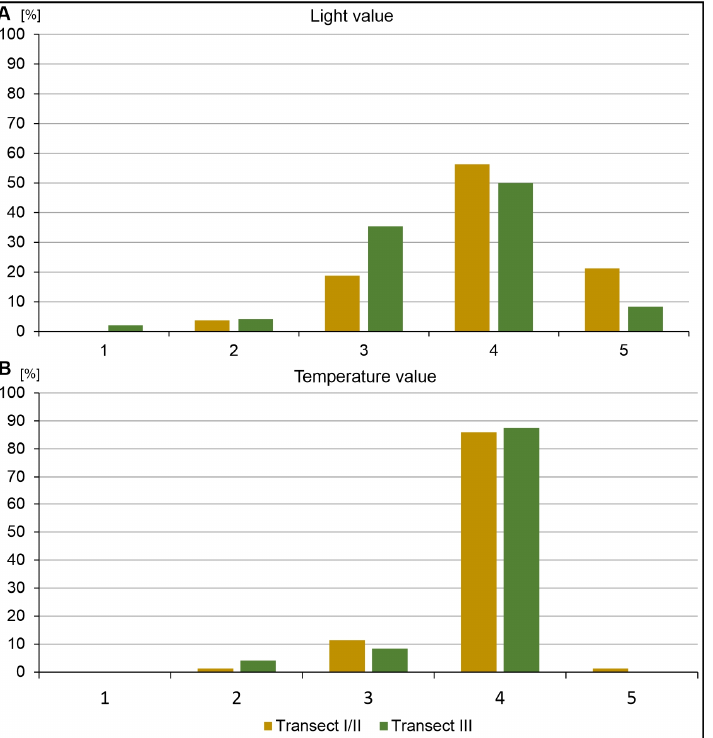
Figure 7. The differentiation of species according to light ( A ) and temperature ( B ) requirement value: